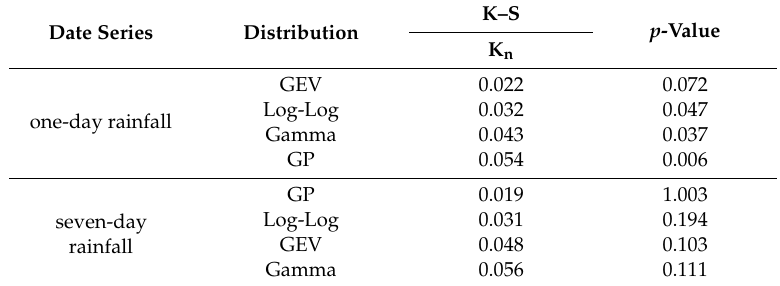
Table 3. Test statistics for the fitted cumulative distribution for one-day and seven-day